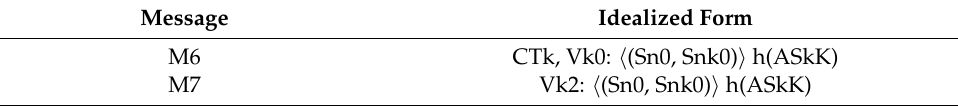
Table 6. Idealized form of the authentication phase of agriculture